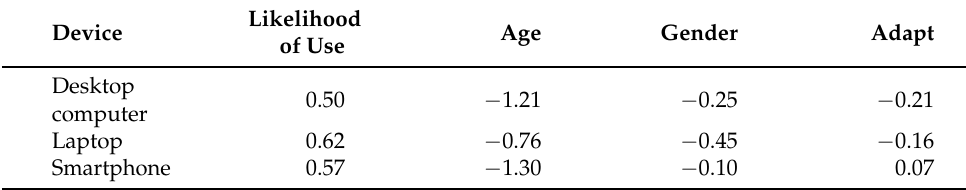
Table A9. Table of the coefficients in the regression